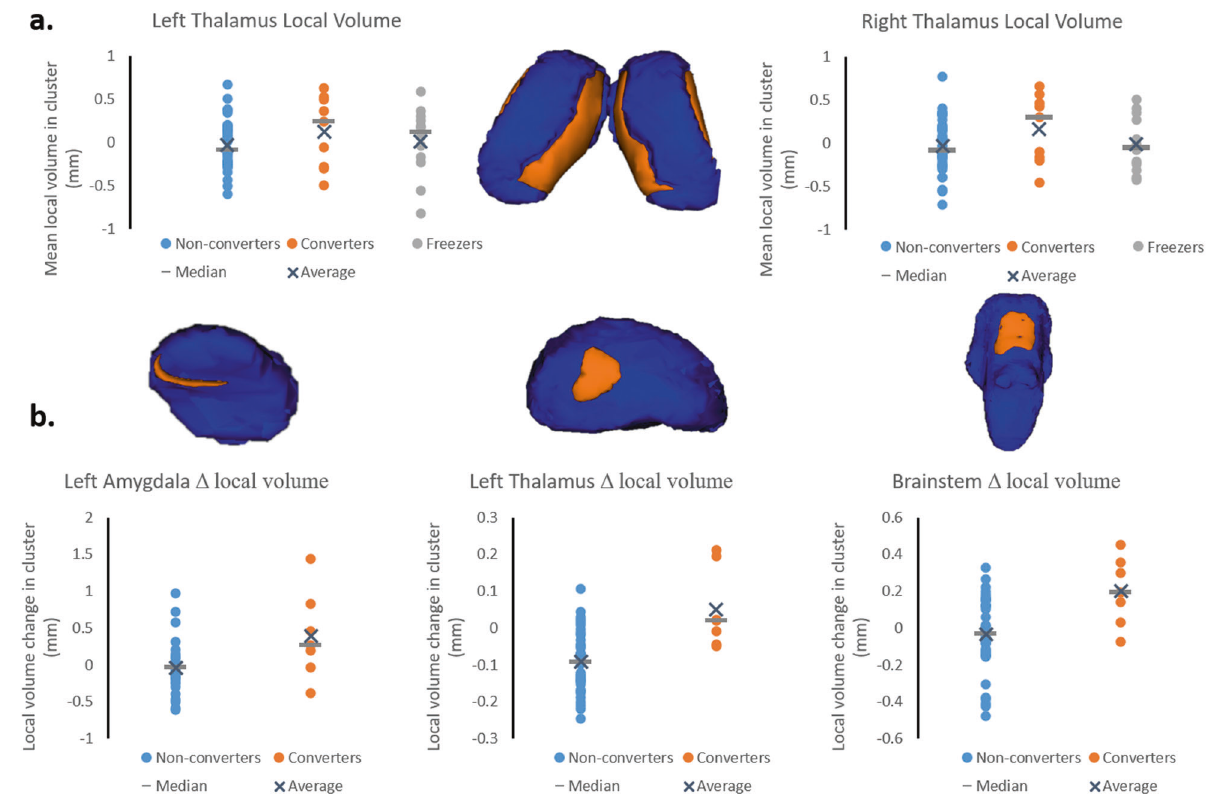
Fig. 2 Local volume alterations at study entry and over two years. Surface models of subcortical structures (in blue) are depicted with signi fi cant clusters (in orange) showing local volume alterations at study entry ( a ) and over two years ( b ). Residual local volume for each participant within thresholded clusters and p -values for the group effect from the ANCOVA accounting for age, gender, and daily levodopa dose is plotted along with median and average group values. a . At study entry, signi fi cant differences in local volume were found in the thalamus bilaterally. Post-hoc tests revealed that converters and freezers showed local in fl ations in the thalamus clusters relative to non- converters. b . Over the two years, signi fi cant changes were observed in local volume in the brainstem, and trends towards signi fi cance in the left amygdala and left thalamus. Converters showed local volume in fl ation in the brainstem, left amygdala, and left thalamus, while non- converters showed de fl ation (see text for details).